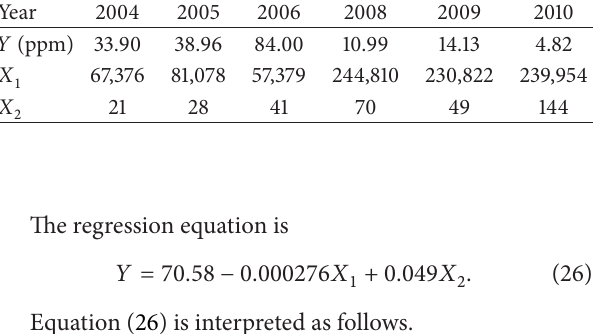
Table 3: Data on registered vehicles. Source: Motor Vehicle Admin-